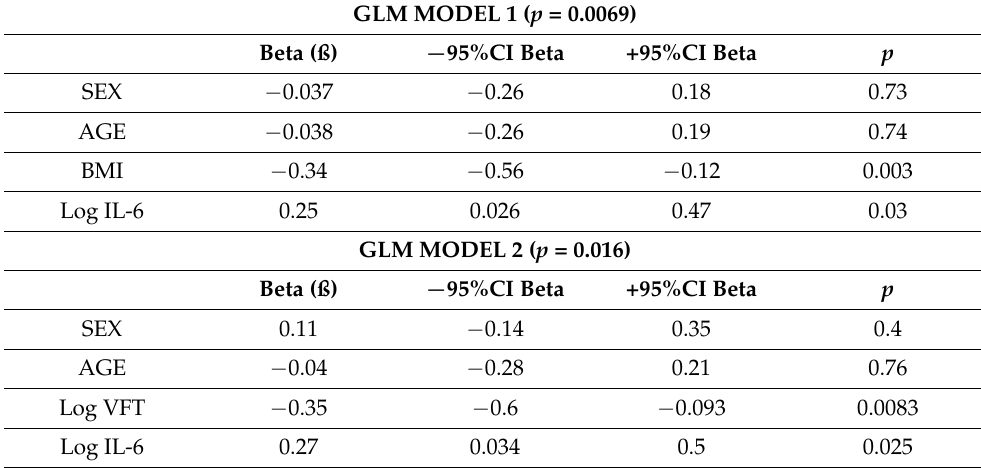
Table 5. General Linear Model (GLM) analysis of independent determinants of ERI value in terms of body composition and inflammatory indicators. (VFT—visceral fat tissue, IL-6—interleukin-6, BMI—body mass